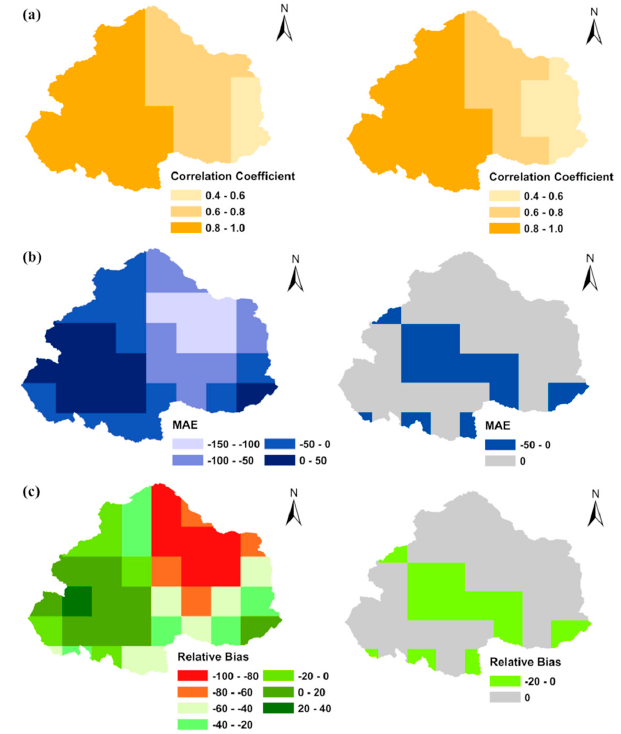
Figure 12. Spatial plot of performance evaluation parameters namely ( a ) correlation coefficient ( r ) ( b ) MAE and ( c ) RBIAS, before (left) and after (right) bias correction of TRMM precipitation for winter season.